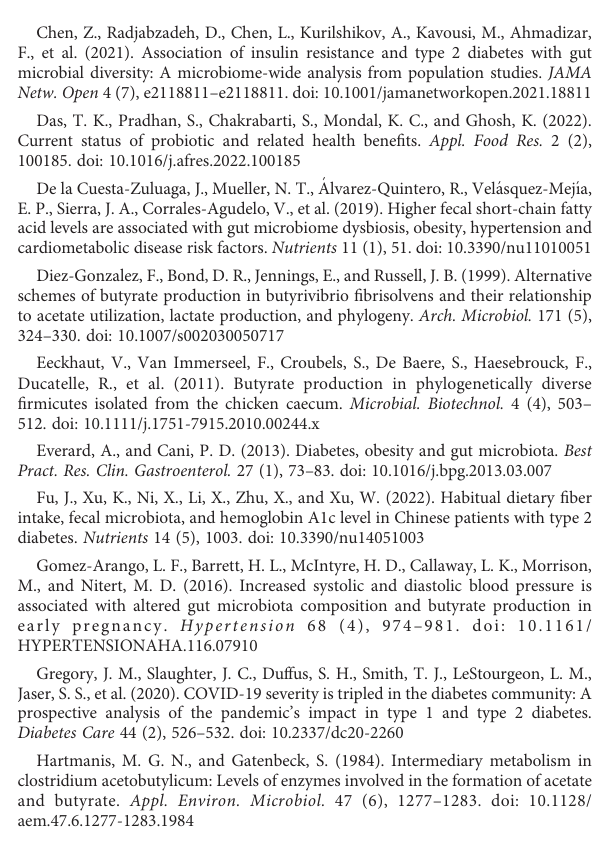
SUPPLEMENTARY FIGURE 1 Inclusion-exclusion criteria for cohort participant data from the time of enrollment to metagenomic sequencing analysis. SUPPLEMENTARY FIGURE 2 Relative abundance of gut microbial phyla per individual across (A) age group, (B) T2DM category and (C) BMI